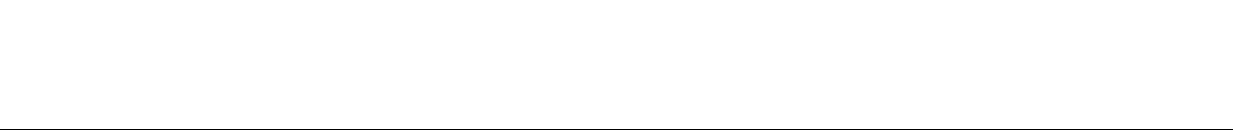
TABLE 1 | Baseline characteristics of the three groups of rhesus macaques ( (cid:1) x ± s)